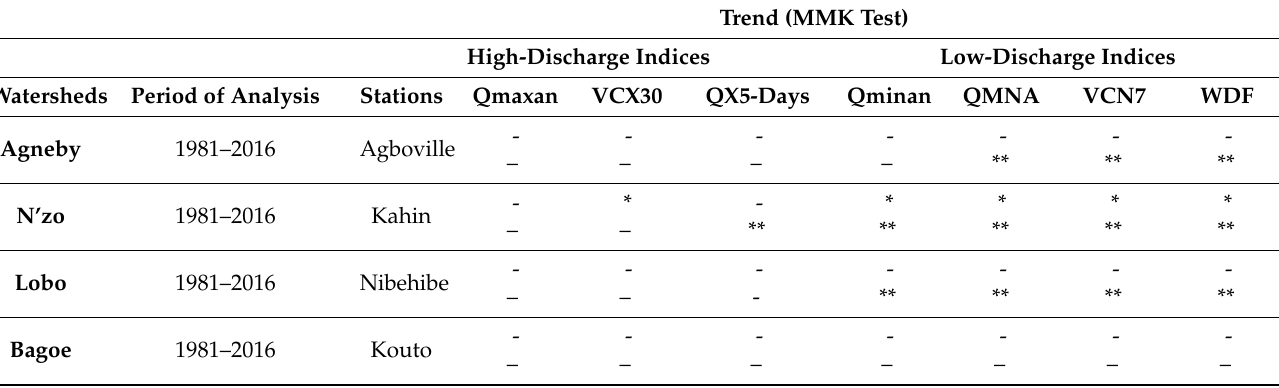
Table 5. A trend analysis for the heterogeneous and homogeneous stations of flood and low- discharge indices in some watersheds in Côte d’Ivoire.